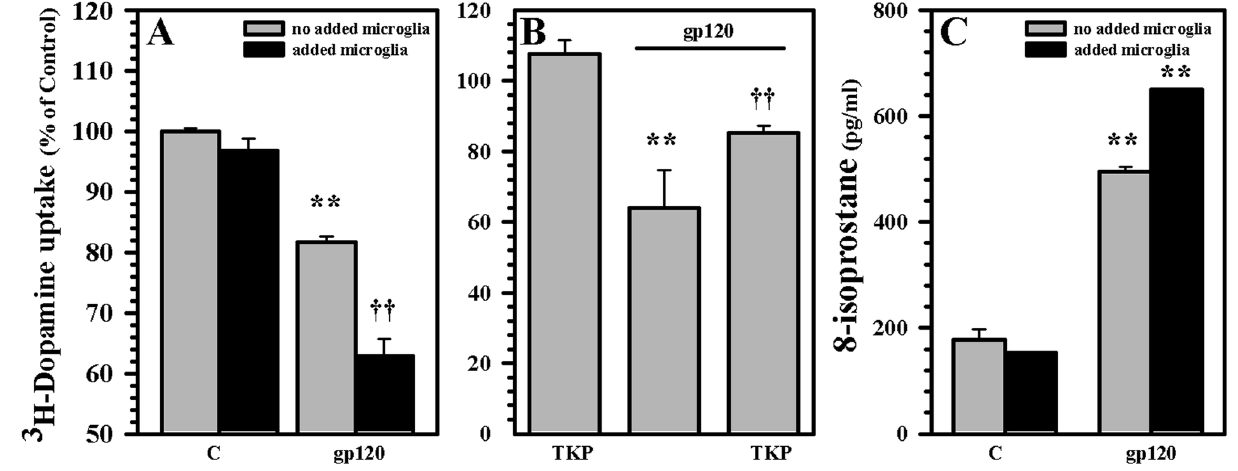
Figure 7. Potentiation of gp120-induced neuronal damage by human microglia. Additional human microglial cells (5x10 4 cell/ well) were added to human mesencephalic neuronal/glial cultures (5x10 5 cell/well) for 3h followed by gp120 treatment for 5 d. DAT activity was measured by 3 H-DA uptake assay A ) with and without added microglia and B ) in the presence of the tripeptide TKP, which inhibits microglial activation. C ) Lipid peroxidation was measured by 8-isoprostane assay. Data are mean ± SD of triplicates and representative of 3 separate experiments using different brain tissue specimens. **p<0.01 vs. respective control; ††p<0.01 vs. gp120.